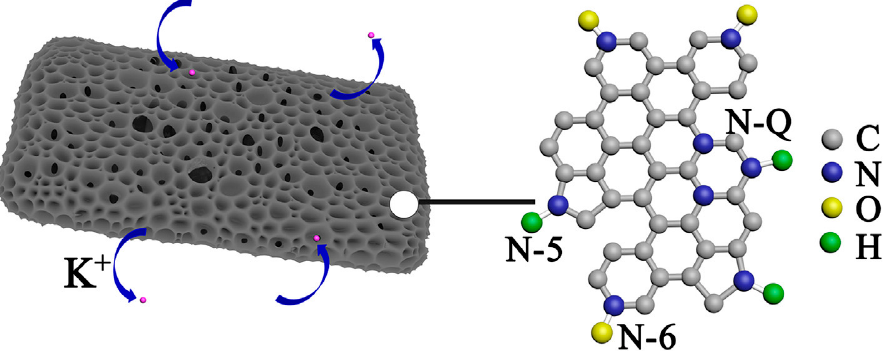
Figure 4. Proposed mechanism of K-ion storage in non-porous biochar. Reprinted with permission from [56]. Copyright 2017, Elsevier.